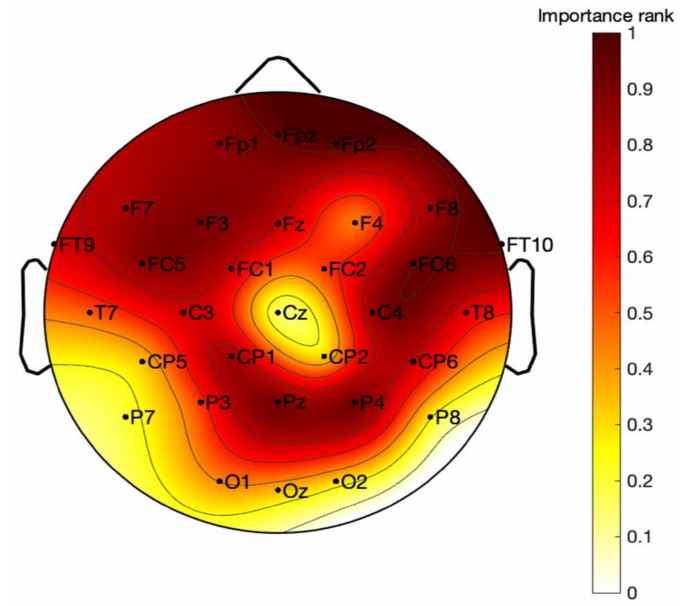
Figure 4. EEG scalp topography of chi-square selection importance rank score in low-beta band. The importance rank is calculated from Equation (9). For example, if low-beta and Fp2 is the 26th variable in ascending order, the importance rank is calculated with 1 − the highest importance ranking score, resulting in a reddish color on the